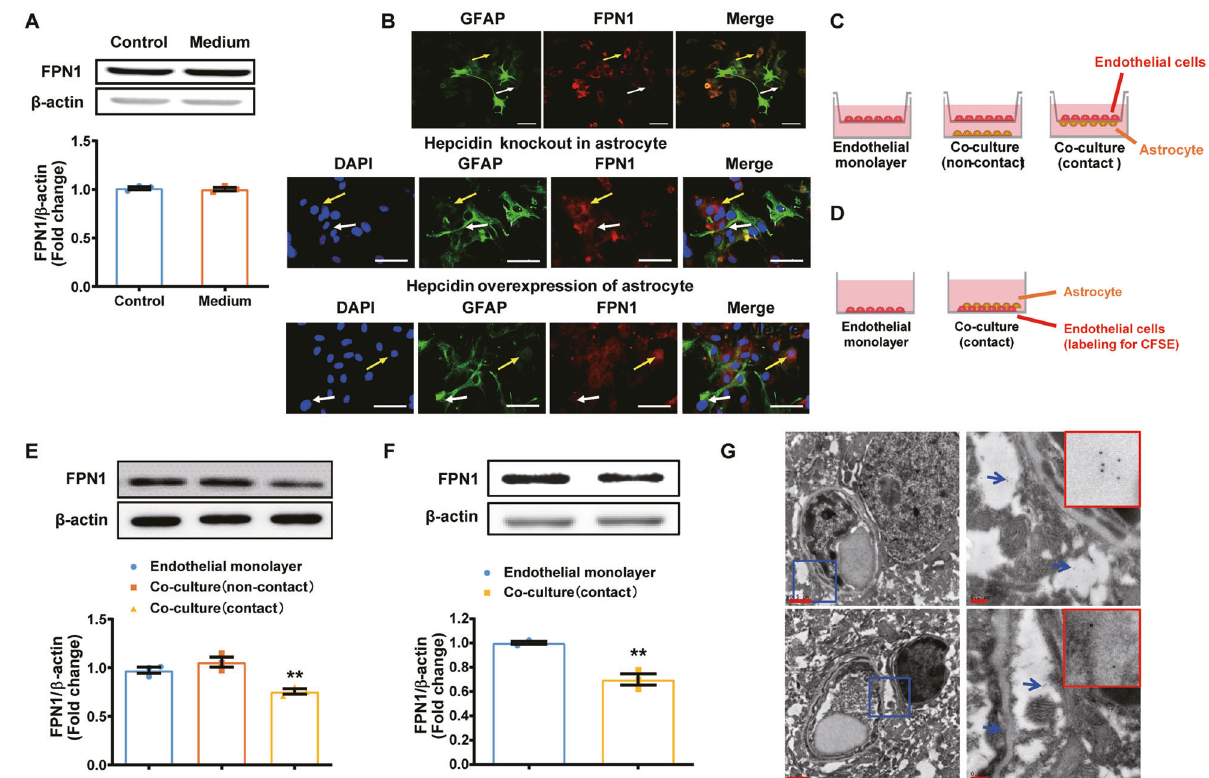
Fig. 4 Hepcidin secreted by the endfeet of astrocytes regulates FPN1 on BMVECs via interfacial physical contact in vitro. A is the protein levels of FPN1 in bEND.3 cells were detected after incubation in medium conditioned by cultured primary astrocytes, n = 3. B are bEND.3 cells that co-cultured with control primary astrocytes, primary astrocytes with hepcidin knockdown or primary astrocytes with hepcidin overexpression. bEND.3 cells not contacting astrocytes are indicated with a yellow arrow; cells in contact with astrocytes are indicated with a white arrow. Scale bar = 50 μ m. C is the schematic representation of the in vitro co-culture test. A bEnd.3 monolayer was grown on a transwell insert with astrocytes grown on the opposite side of the transwell or on the bottom of the culture dish. D is the schematic representation of the in vitro co-culture test. bEnd.3 cells were labeled with CFSE, and primary astrocytes were grown on the bottom of the culture dish. E , F are western blot analysis of FPN1 levels in groups treated as in C and D . The relative expression levels were normalized to β -actin levels and expressed as the mean ± SEM, n = 3, ** p < 0.01. G The locations of hepcidin were determined by immuno-EM in